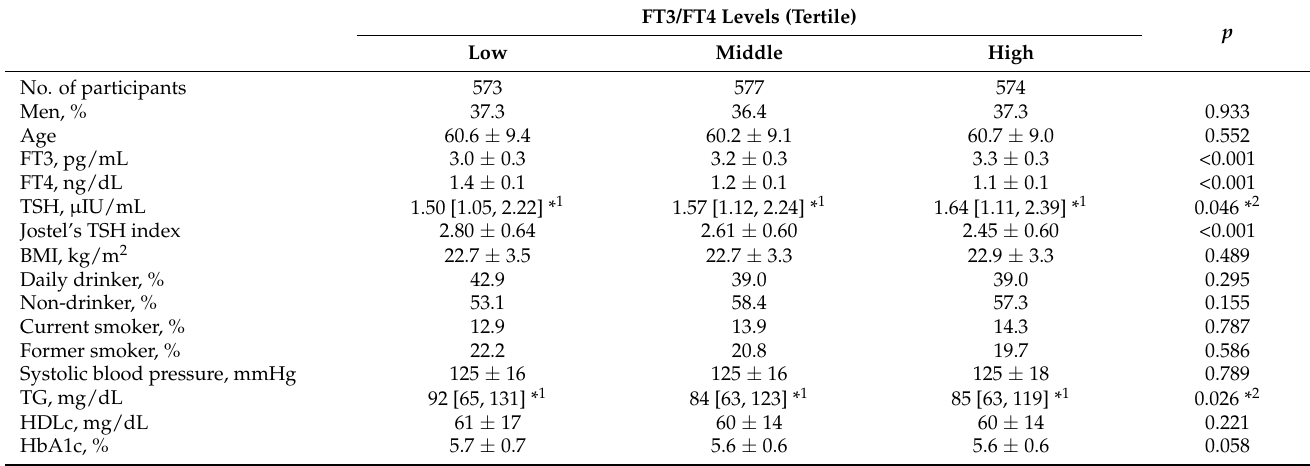
Table 1. Characteristics of study population in relation to